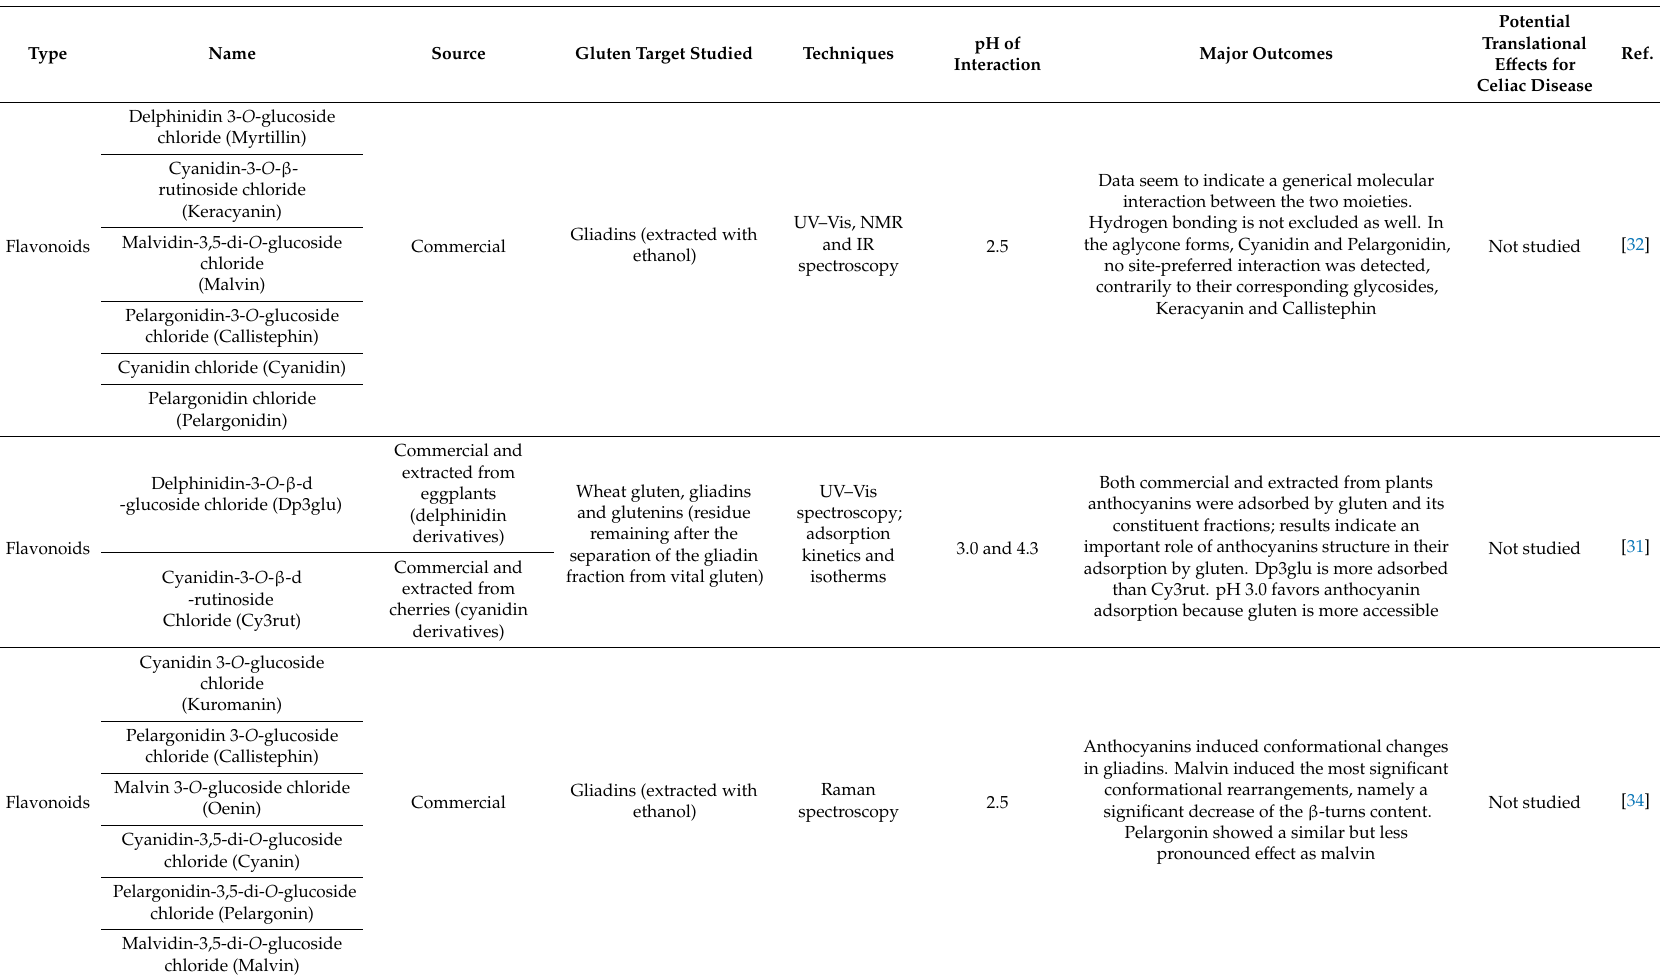
Table 1. An overview of the major studies on the interaction between gluten proteins and phenolic compounds, and its relevance to celiac